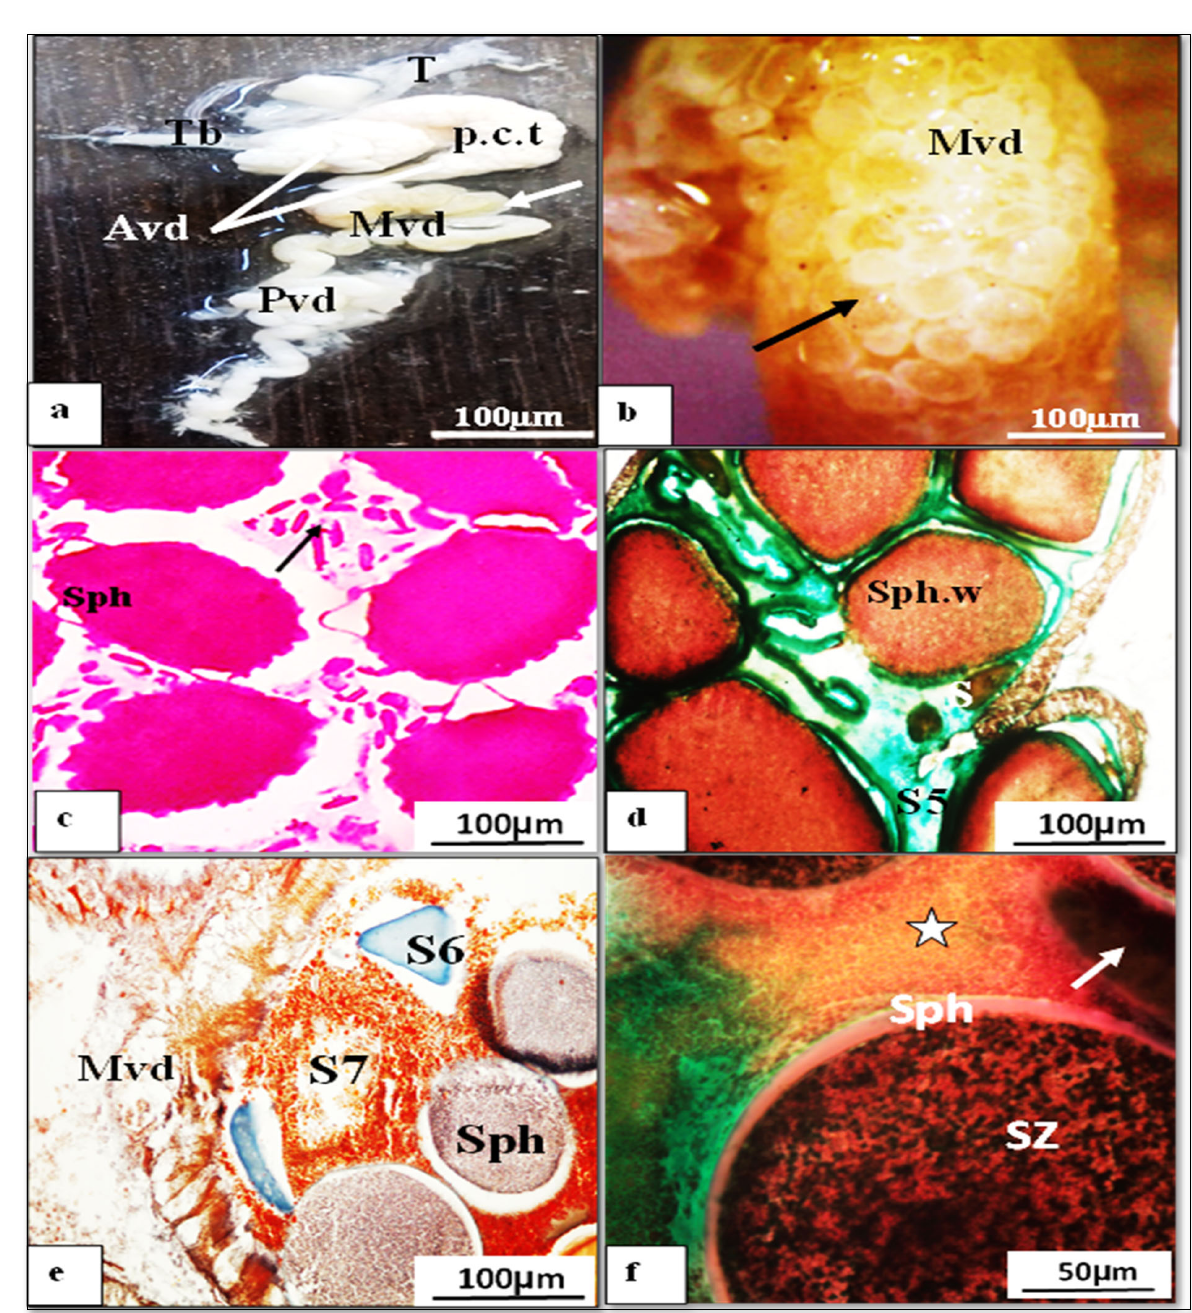
Figure 8. Photograph of the isolated right side of an early mature male genital system showing: testes (T), anterior vas deferens (AVD), posterior coiled mass (p.c.t), middle vas deferens (MVD), posterior vas deferens (PVD), transverse bridge (Tb), V- shape (arrow) ( a ). Stereoscopical picture of the middle vas deferens (MVD) showing: spermatophores (black arrow) ( b ). Photomicrograph of a transverse section of the middle vas deferens showing: spermatophore (Sph) and rod ‐ shaped secretion 6 (black arrow) (PAS) ( c ). Photomicrograph of a transverse section of middle vas deferens showing: spermatophore (Sph) with S5 and S6 secretions (Mallory’s triple stain) ( d ). Photomicrograph of a transverse section of middle vas deferens showing: spermatophore (Sph), rod ‐ shaped secretion S6, and granular secretions S7 (Mallory’s triple stain) ( e ). Photomicrograph of a transverse section of middle vas deferens showing: mature spermatophore (Sph), rod ‐ shaped S6 secretion, and granules shape S7 secretions (Masson’s trichrome) ( f ).